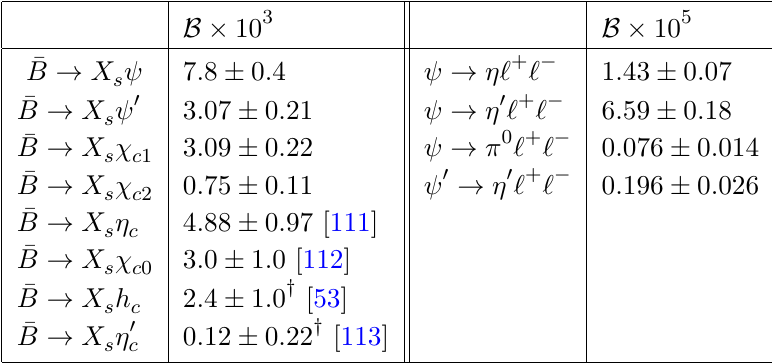
are NRQCD estimates, and unless y